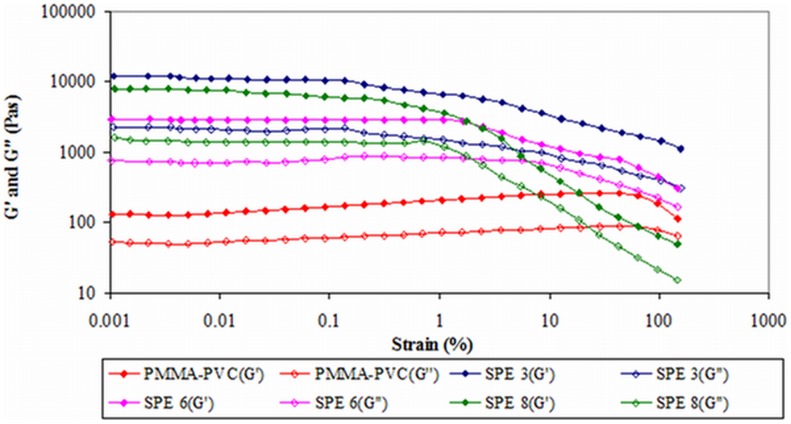
Amplitude sweep of second system.